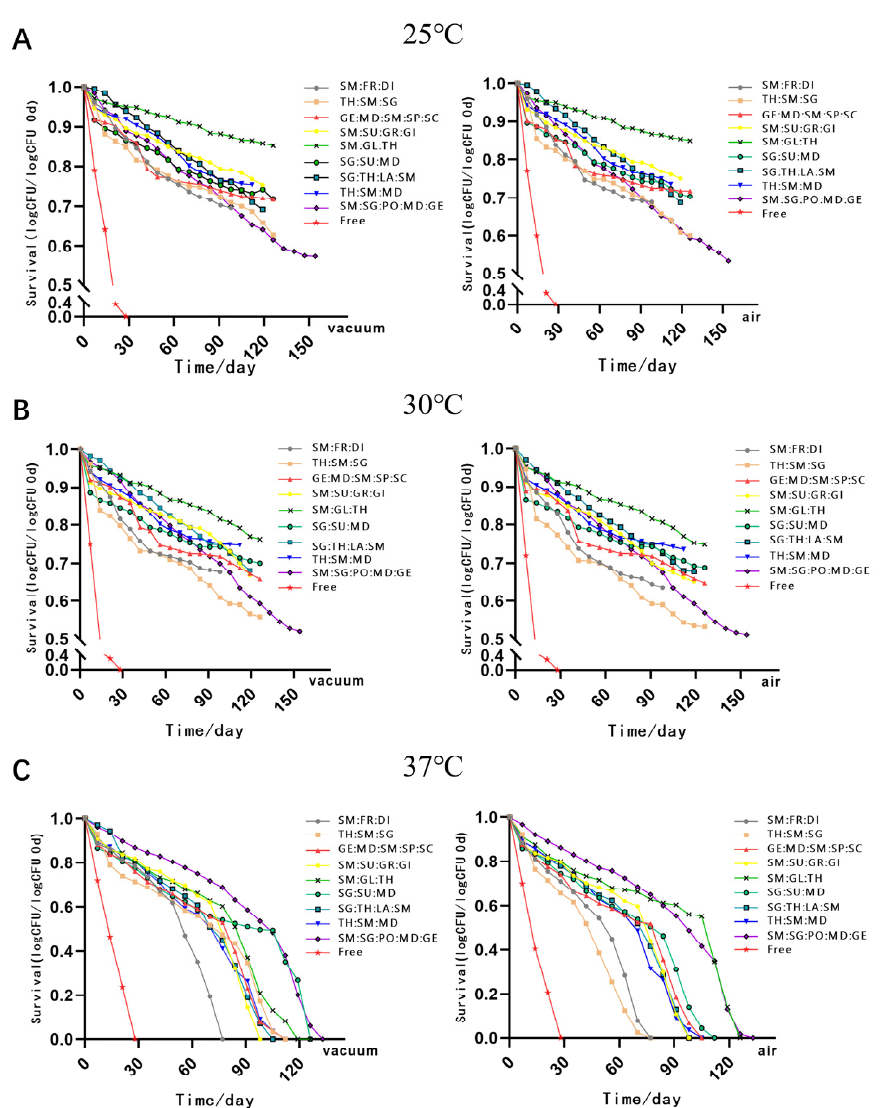
Figure 2. The number of viable cells in the microencapsulated LR-LFCA stored at 25 °C ( A ), 30 °C ( B ), and 37 °C ( C ) under two different storage atmospheres: air or vacuum.